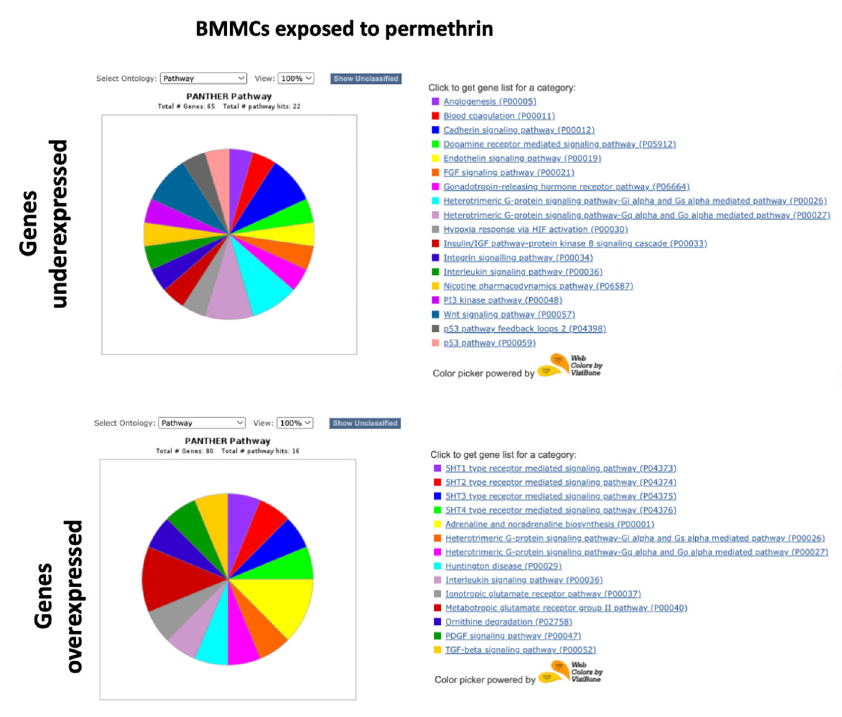
Figure 7. Pathway ontology analysis in BMMCs exposed to permethrin.